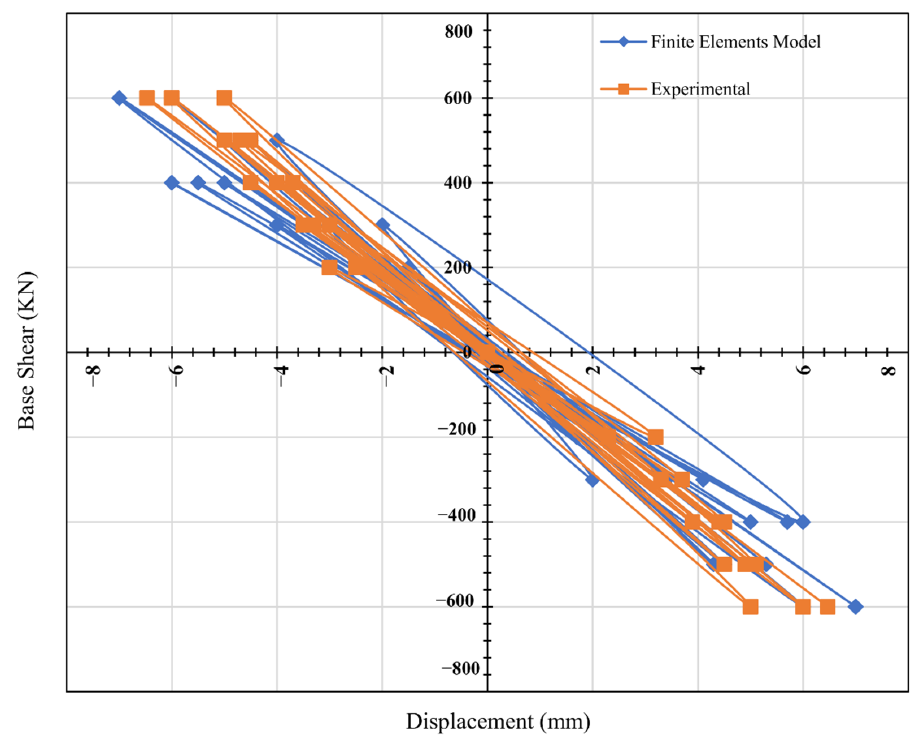
Figure 4. Comparison of deformation ‐ load in the numerical and experimental model for